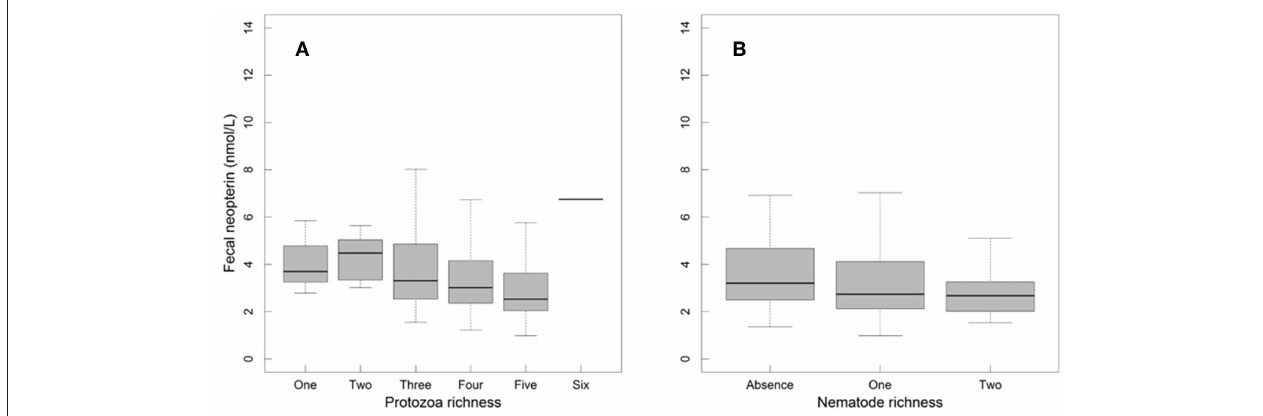
FIGURE 3 | Fecal neopterin concentrations (raw data) across male and female mandrills of all ages in relation to protozoa richness (A) and nematode richness (B) . Sample sizes for panel A included 67 individuals and 372 samples broken as follows: 3 samples for the category of 1 parasite, 12 for two, 44 for three, 123 for four, 189 for five and 1 for six. Sample sizes for panel B included 67 individuals and 372 samples broken as follows: 111 samples for the category of zero parasite, 213 for one and 30 for two. For both panels, the bottom and top of the box, respectively, represent the 25th and 75th quartiles, and the bold horizontal line represents the median.